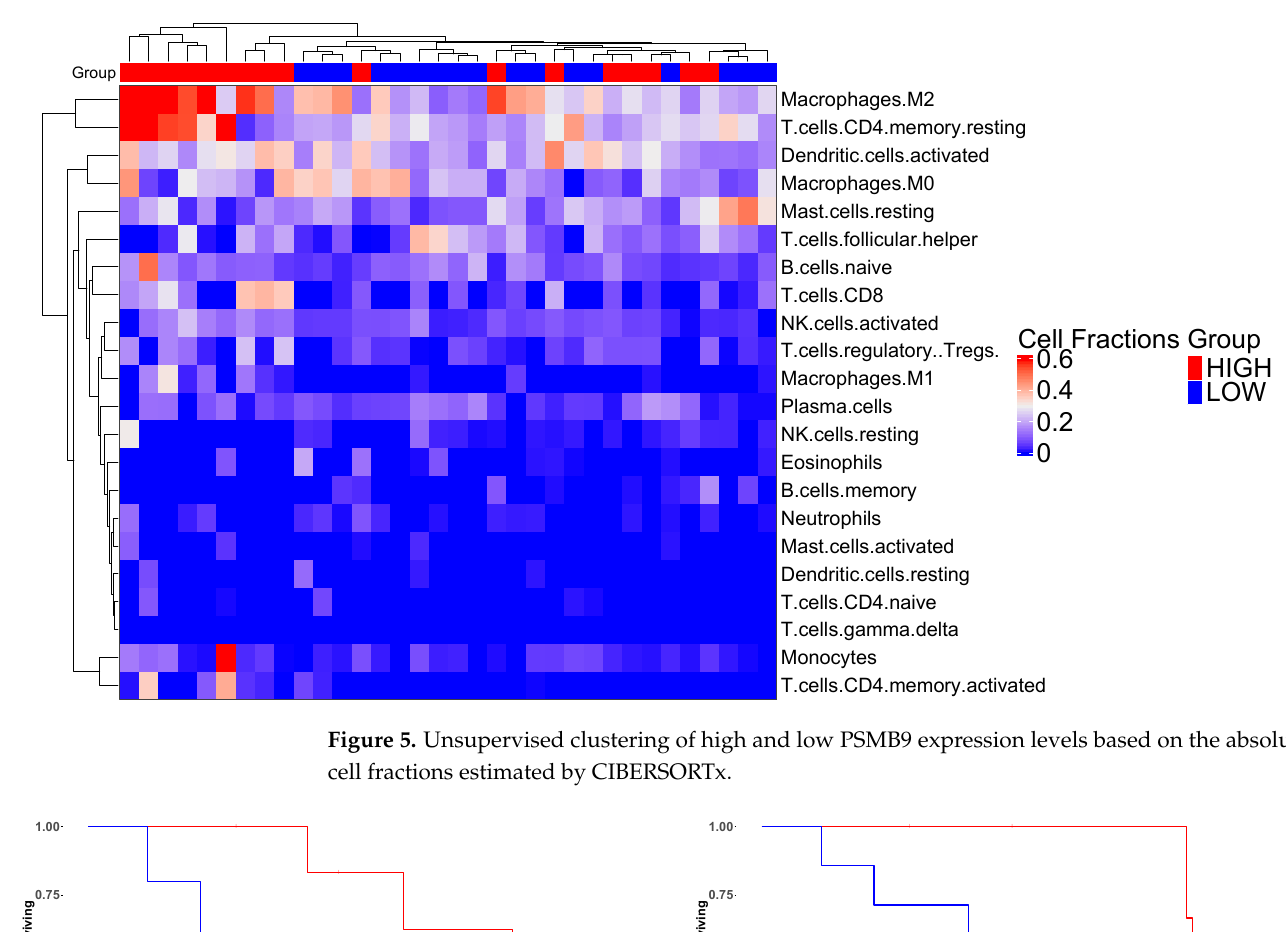
9 of 14 Figure 4. Correlation matrix of genes related to IFN γ signaling through the JAK/STAT1 pathway in all uLMS samples in the 1st and 4th quartiles. All values inside each cell correspond to Pearson correlation coefficient at the 0.05 level. 3.3. Overexpression of the Immunoproteasome PSMB9 Subunit Is Correlated with uLMS Patients’ Survival Outcome